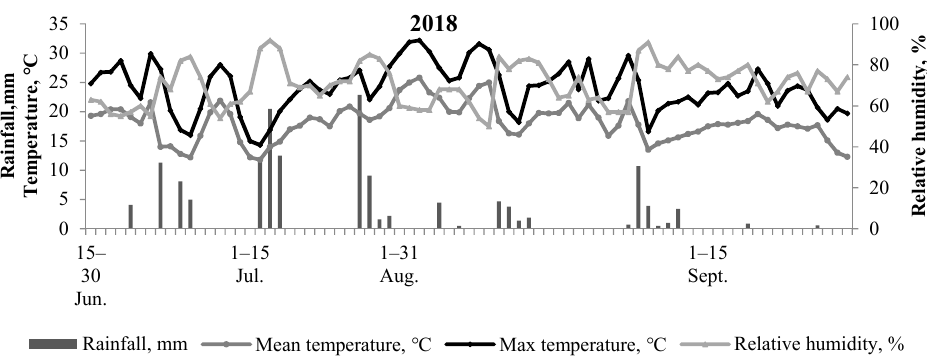
Figure 1. Weather conditions in